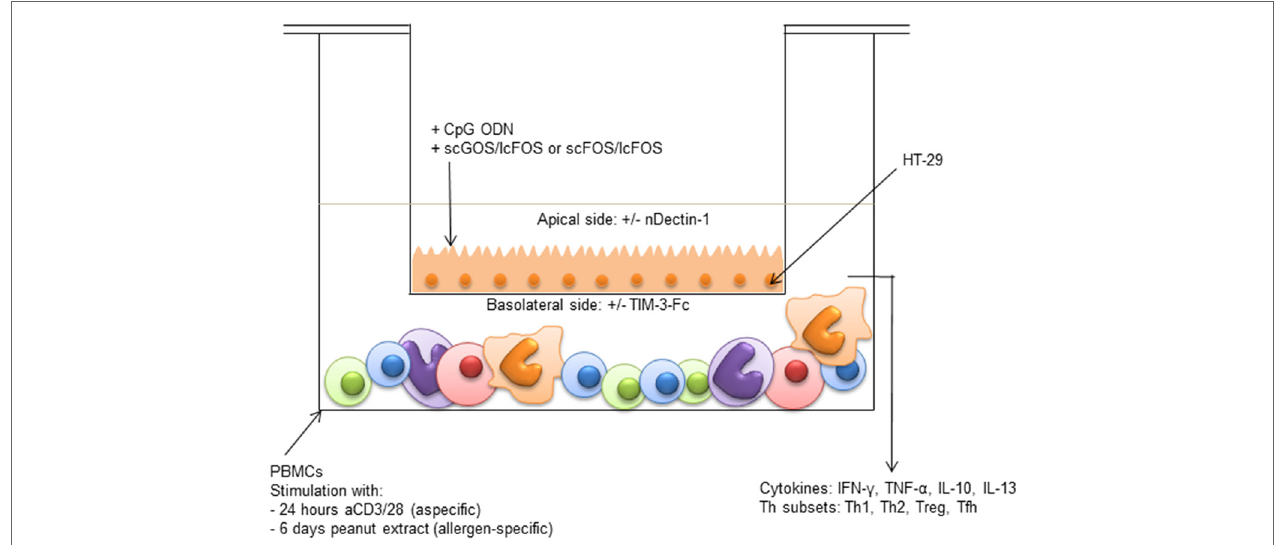
FigUre 1 | Intestinal epithelial cells (IEC) transwell co-culture model HT-29 cells (IECs) cultured in transwells were apically exposed to synthetic CpG oligodeoxynucleotides in the presence or absence of either short-chain galacto-oligosaccharides and long-chain fructo-oligosaccharides (scGOS/lcFOS) or scFOS/ lcFOS. Simultaneously, 3 × 10 6 peripheral mononuclear cells (PBMCs) in the basolateral compartment were either stimulated aspecifically for 24 h with aCD3/CD28, or for 6 days with peanut extract. Basolateral cytokine production and T cell polarization were measured. After 24 h, the insert of the aspecific model was transferred to a new plate with fresh medium, to measure production of galectin-9 by IECs. The contribution of dectin-1 and galectin-9 in the peanut-specific model was investigated by either neutralizing dectin-1 with an antibody on the apical side, or by neutralizing galectin-9 with TIM-3-Fc on the basolateral